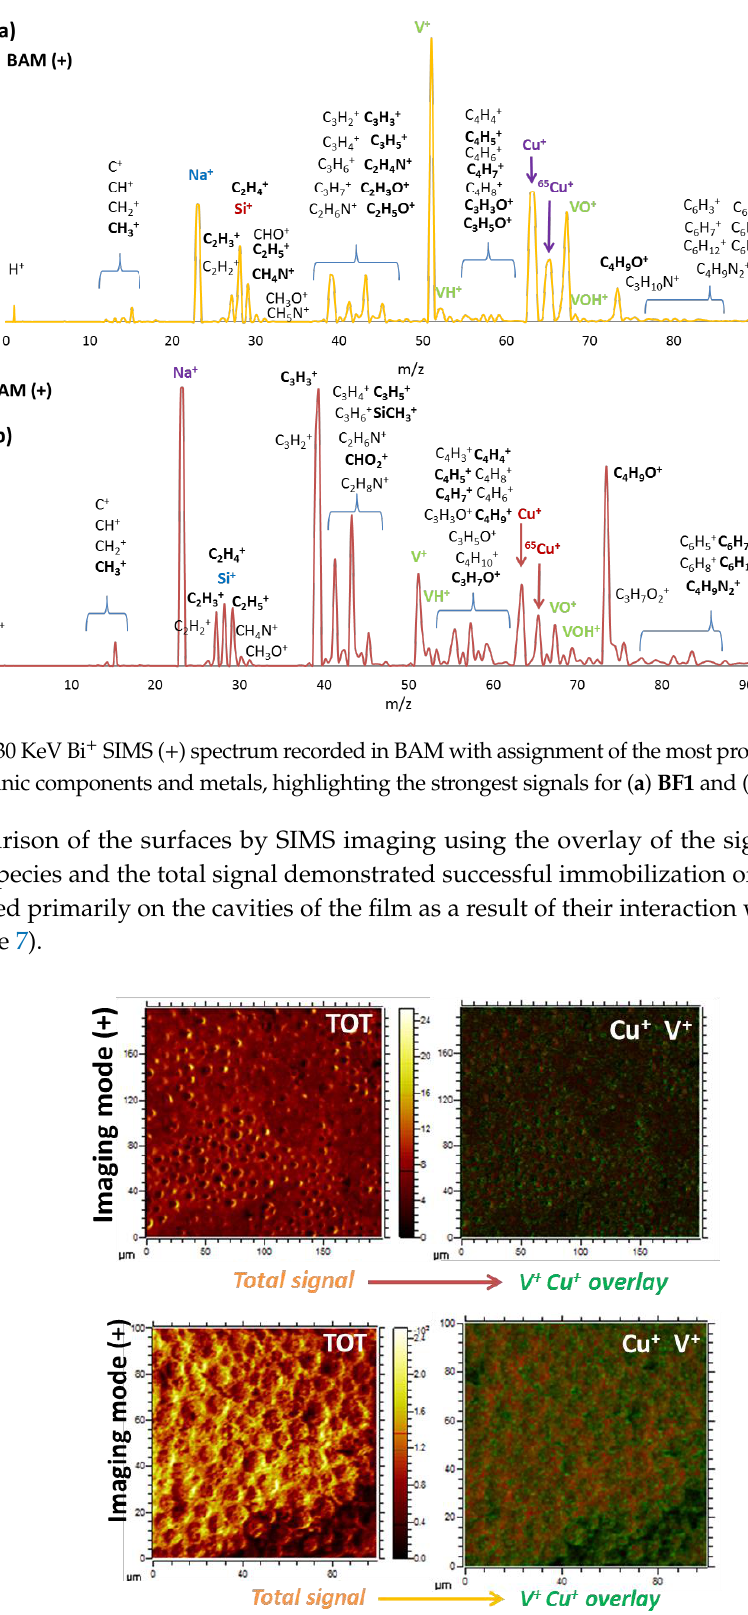
Figure 7. ToF-SIMS surface images obtained in imaging mode ( + ) are also shown and indicate the spatial distribution of the signals arising from the Cu + (green) and V + (red) peaks as an overlay on the right image for BF1 (top) and BF2 (bottom).